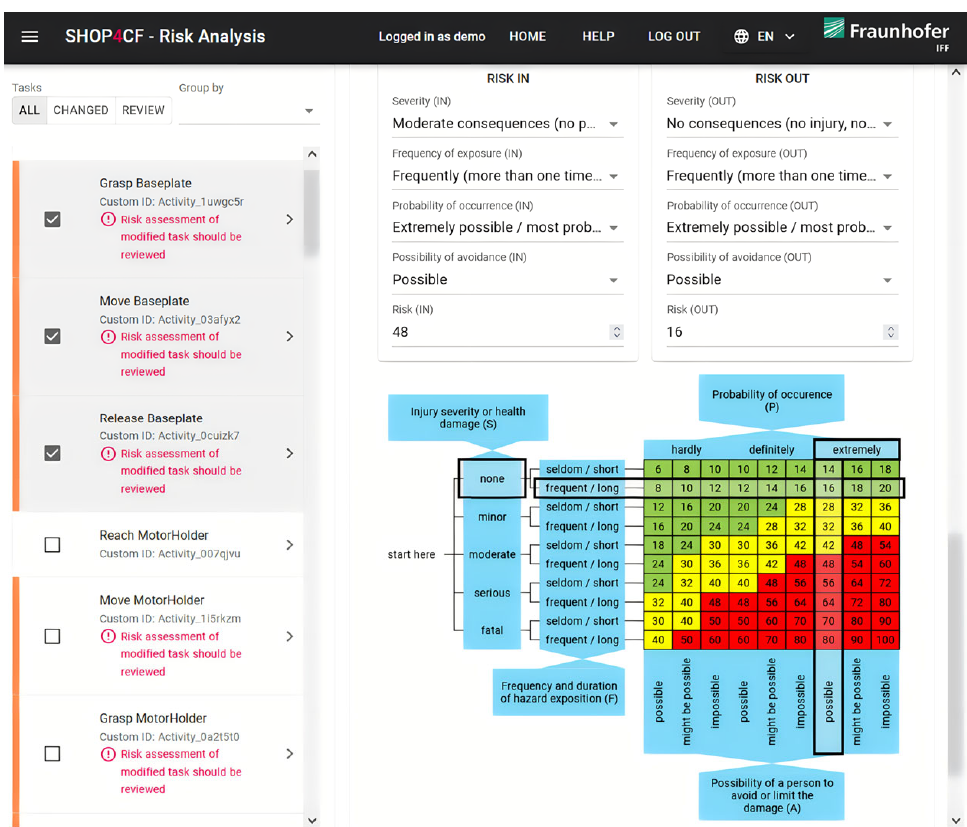
Figure 10. Updating the risk assessment. Using the “review” function, only tasks featuring a change need to be reviewed ( left ). These can be grouped according to resource so that all tasks featuring the changed gripper “Gripper-GEH6040IL_VAC-Smooth” are simultaneously edited. The mitigation methods are updated to indicate the changed minimum contact area and newly allowed maximum speed ( right ).